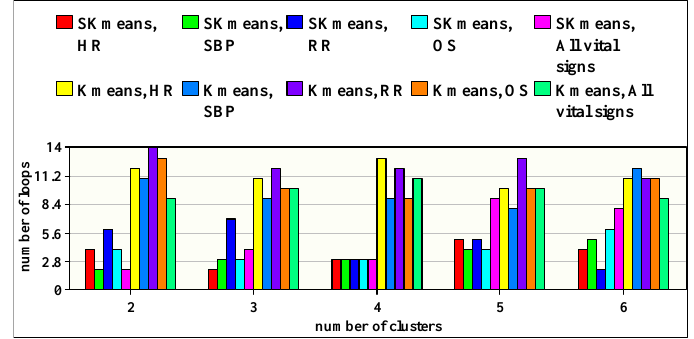
Figure 7. Number of iterations when applying SKmeans and traditional Kmeans.